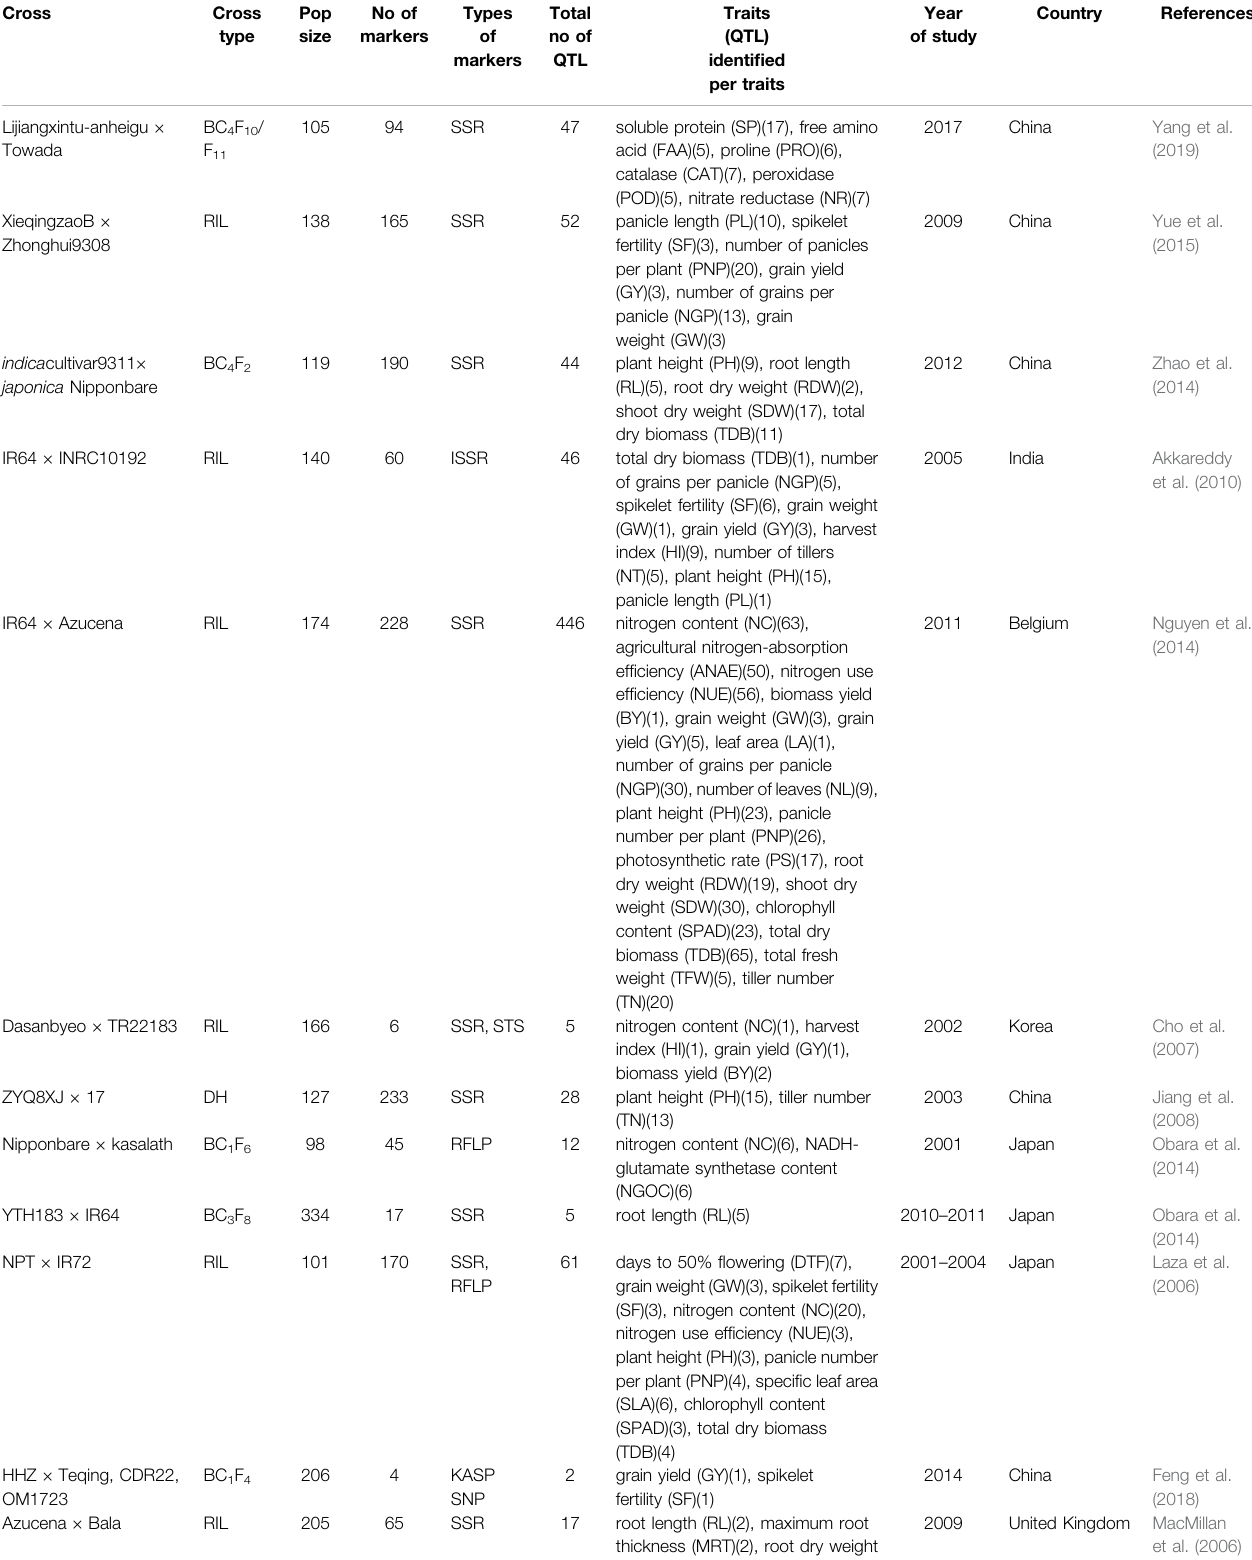
TABLE 1 | ( Continued ) Summary of the QTL studies used in the QTL meta-analysis for the nitrogen use ef fi ciency and related traits in